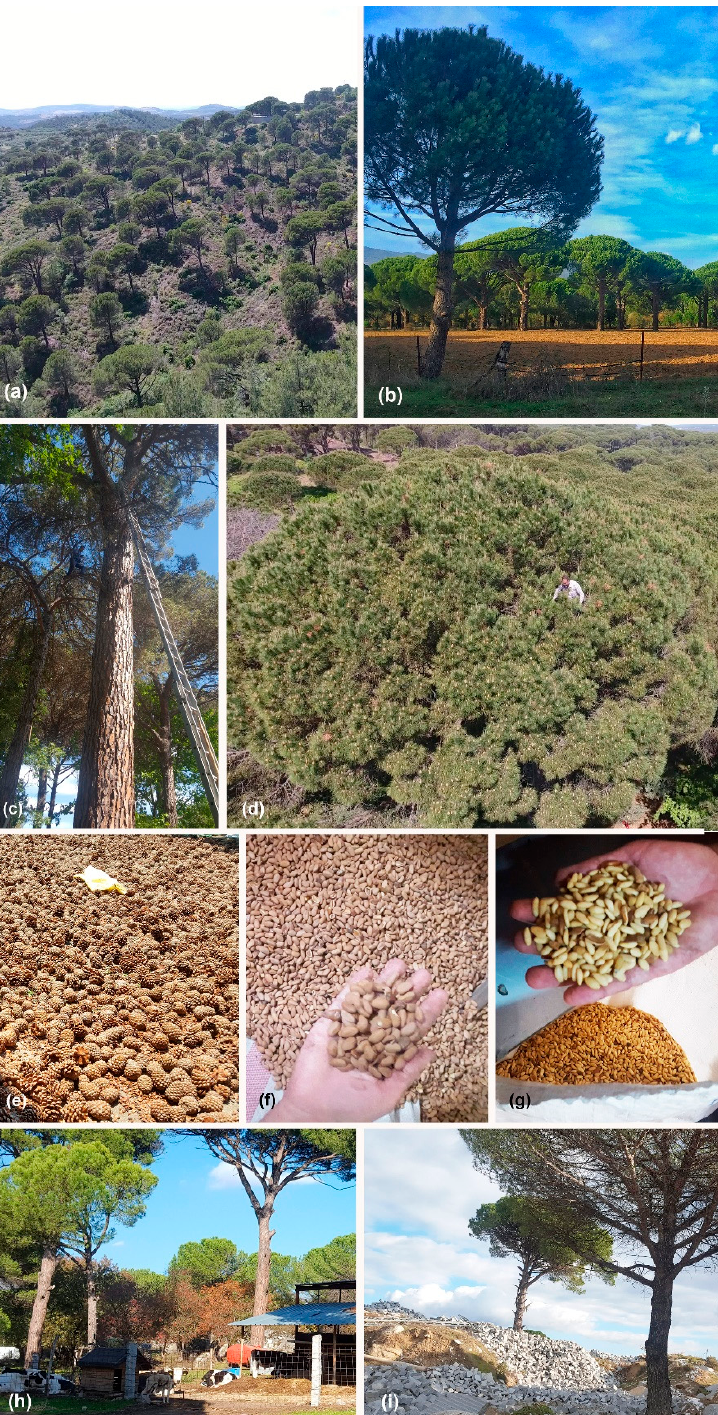
Figure 2. Descriptive photographs of Stone pines in the Kozak Basin. General view of Stone pine forests ( a ); Agroforestry implementing ( b ); Traditional harvesting ( c , d ); Manufacturing from cones ( e ) and kernels ( f ) to pine nuts ( g ), Livestock ( h ), Granite quarries ( i